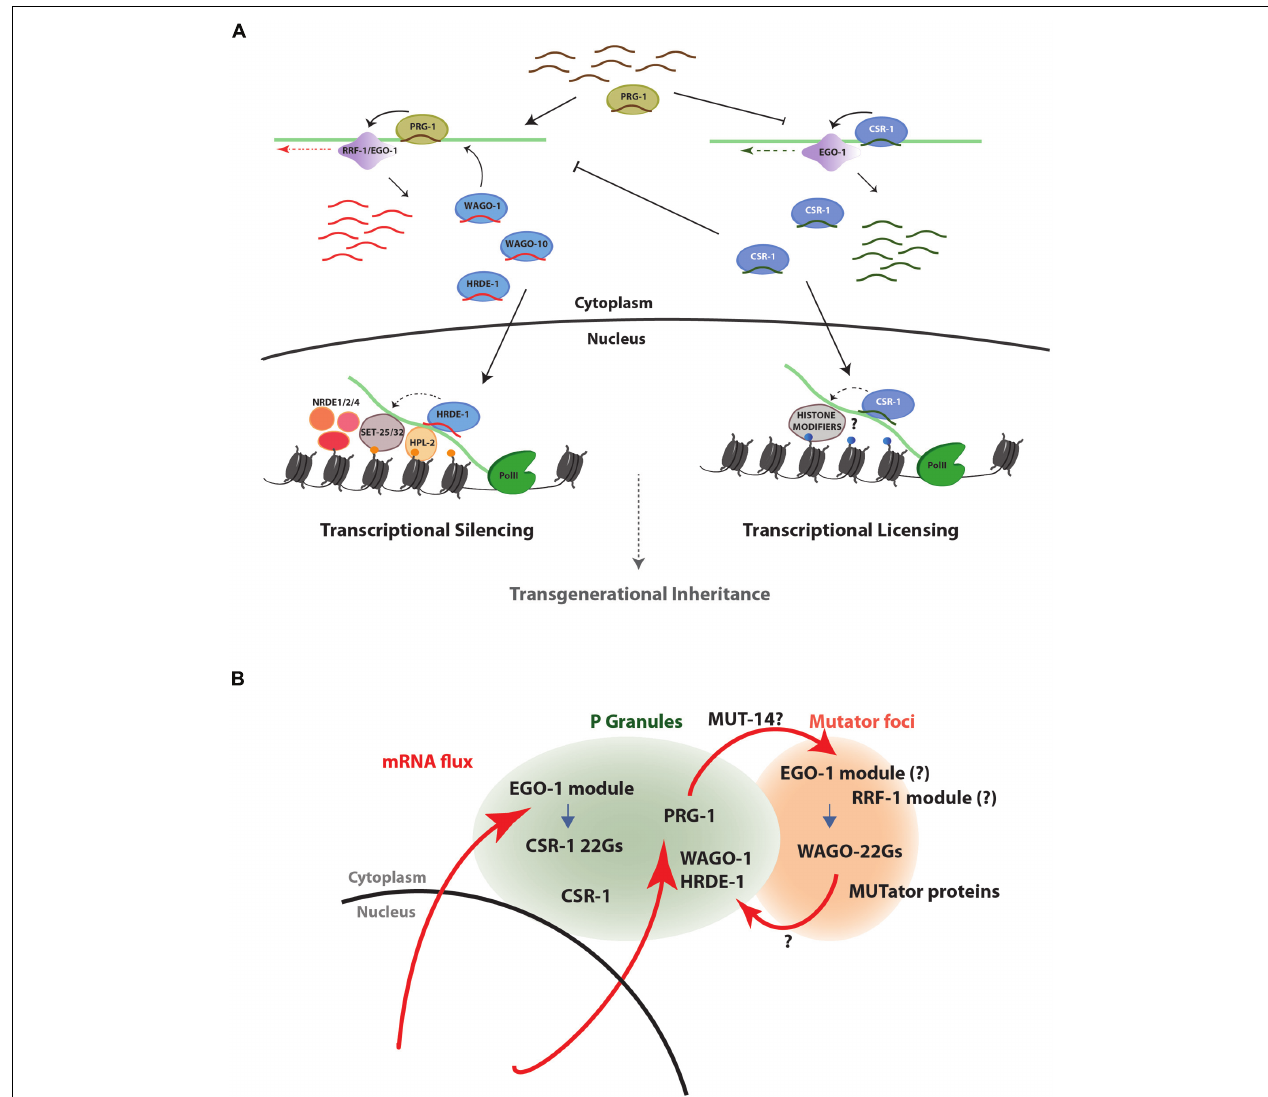
pathways appear to be mutually exclusive and self-reinforcing, and at the genetic level each inhibits the activity of the other. (B) Schematic representation of a model for germline mRNA flux through perinuclear P granules and nearby Mutator foci, to which many 22G-RNA pathway components localize. The model proposes that germline transcripts pass through P granules as they exit the nuclear pore, where they are scanned for complementarity to CSR-1 and PRG-1/WAGO class 22G-RNAs. Transcripts targeted by CSR-1 are protected from targeting to the WAGO 22G-RNA biosynthesis machinery and thus escape silencing. On the other hand, transcripts not targeted by CSR-1 but with target sites for piRNAs may be transported to Mutator foci for amplification of WAGO-class 22G-RNAs and downstream silencing.